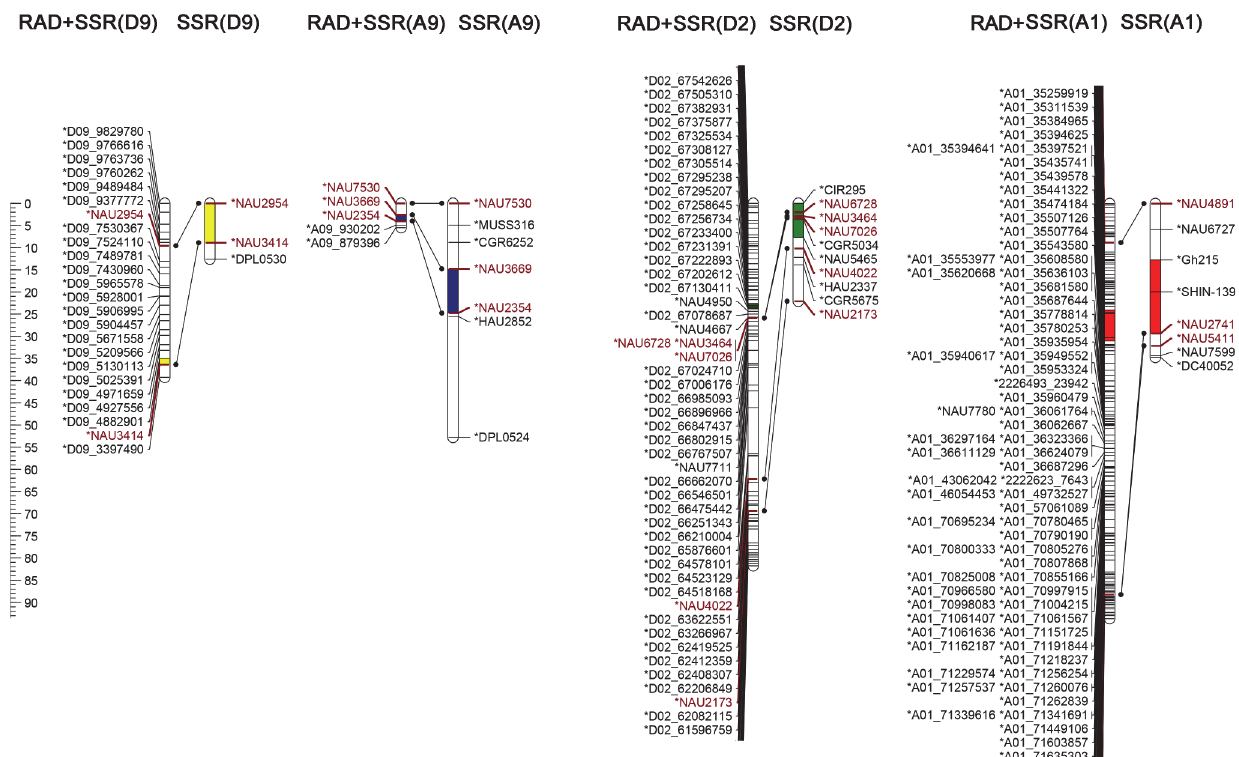
Fig 3. QTLs for VW resistance in two maps. Four QTLs for VW resistance, qVW-D9-1 , qVW-A9-1 , qVW-D2-1 , qVW-A1-1 were identified on both maps, with different colors indicating different 2-LOD intervals for each QTL. Maps were constructed with RAD markers plus SSR markers, and with SSR markers alone. Lines connecting the same markers in these two maps correlated the trait: these markers are colored brown.